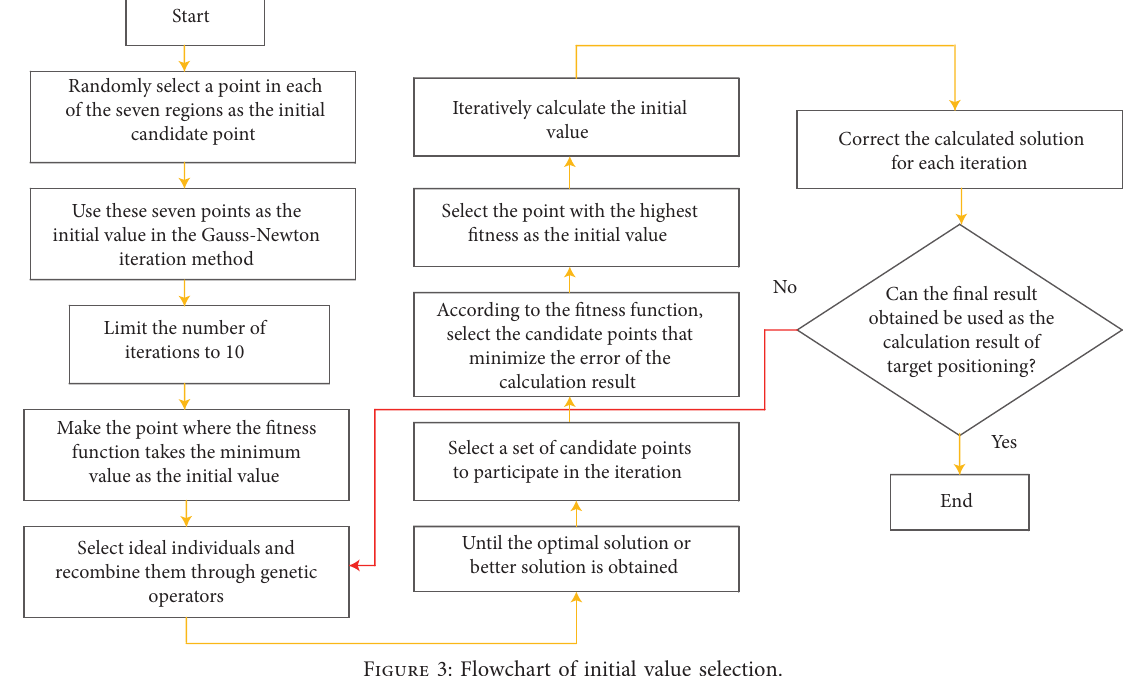
Figure 3: Flowchart of initial value selection.